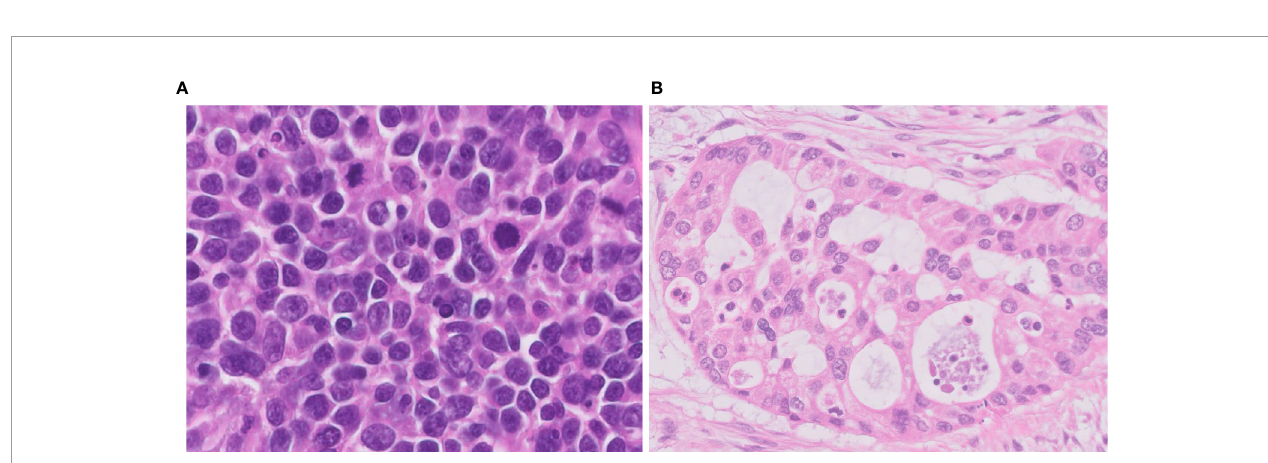
FIGURE 2 | Dif fi culties in differential diagnosis of LCNEC. (A) This tumor is LCNEC that needs to be differentiated from SCLC; cell size is larger than that of SCLC. (B) This LCNEC needs to be differentiated from adenocarcinoma; the tumor shows pseudoglandular structures forming cribriform pattern. Magni fi cation: